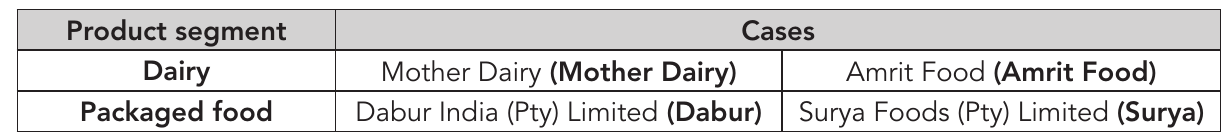
Table 4: Set up of research